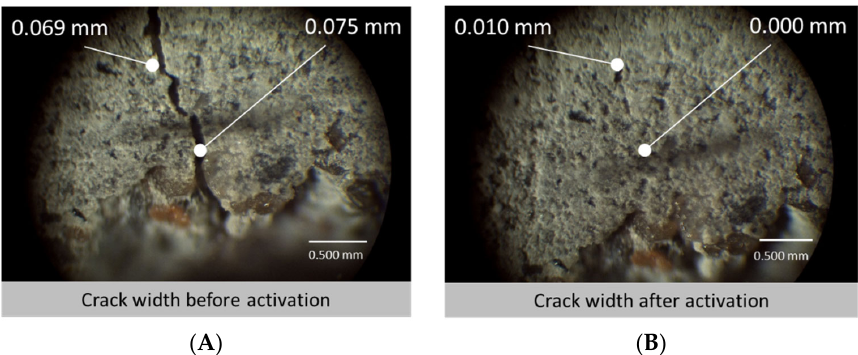
Figure 10. Microscope image of a crack in cementitious sample with knotted shape memory polymers fibres in aligned distribution (AD) before activation ( A ) ad after activation ( B ), adapted from [45].